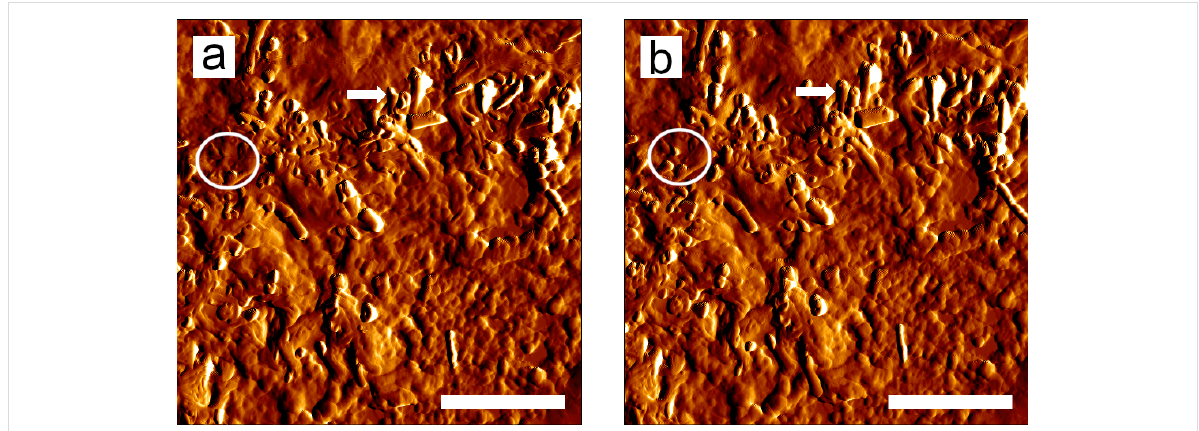
Figure 4: Comparison of AFM images of recrystallized wax on glass (a) 45 and (b) 71 min after the application of the wax solution. The circles indi- cate the formation and the arrows the elongation of the tubules. Scale bars: 2 µm.